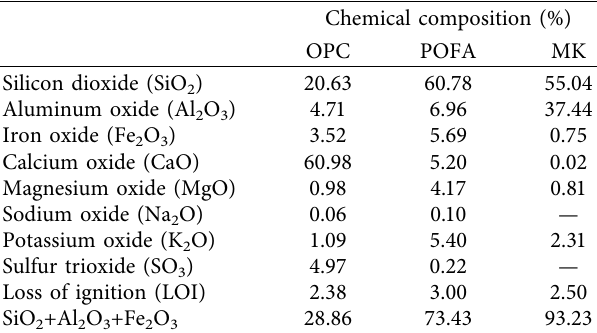
Table 2: Chemical composition of